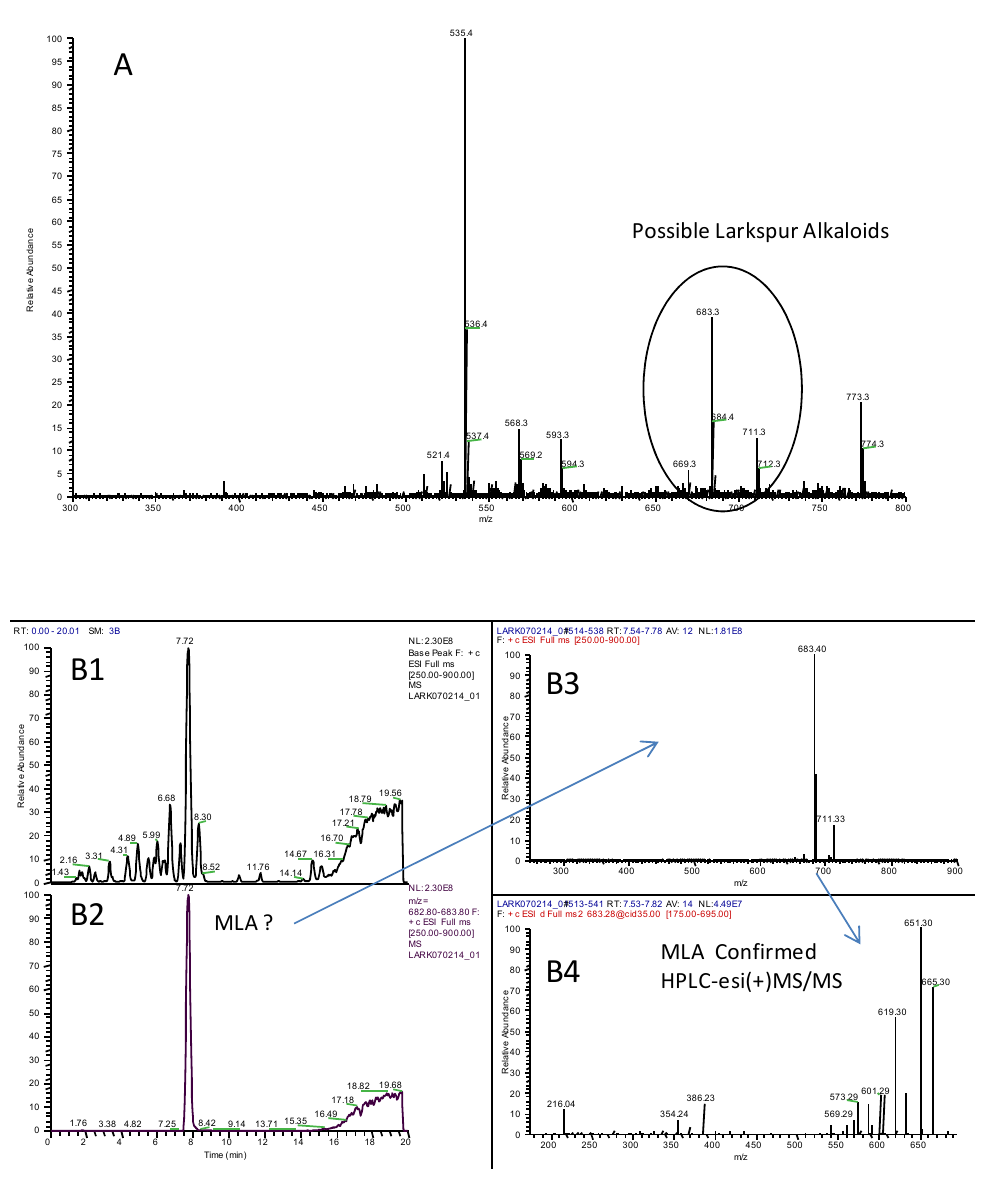
Figure 4. ( A ) MS spectrum of crude rumen extract obtained from a dead cow involved in possible rangeland plant poisoning case and analyzed by flow-injection esi(+)MS. Possible larkspur alkaloids in the rumen were indicated by ions at m / z 669, 683 and 711 that are consistent with those found in the low larkspurs ( B1 ); HPLC-esi(+)MS/MS ion chromatogram obtained after isolation of the crude alkaloid fraction by acid/base extraction ( B2 ); extracted ion chromatogram for m / z 683 and possible detection of the alkaloid methyllycaconitine (MLA) ( B3 ); and confirmed by its MS/MS spectrum ( B4